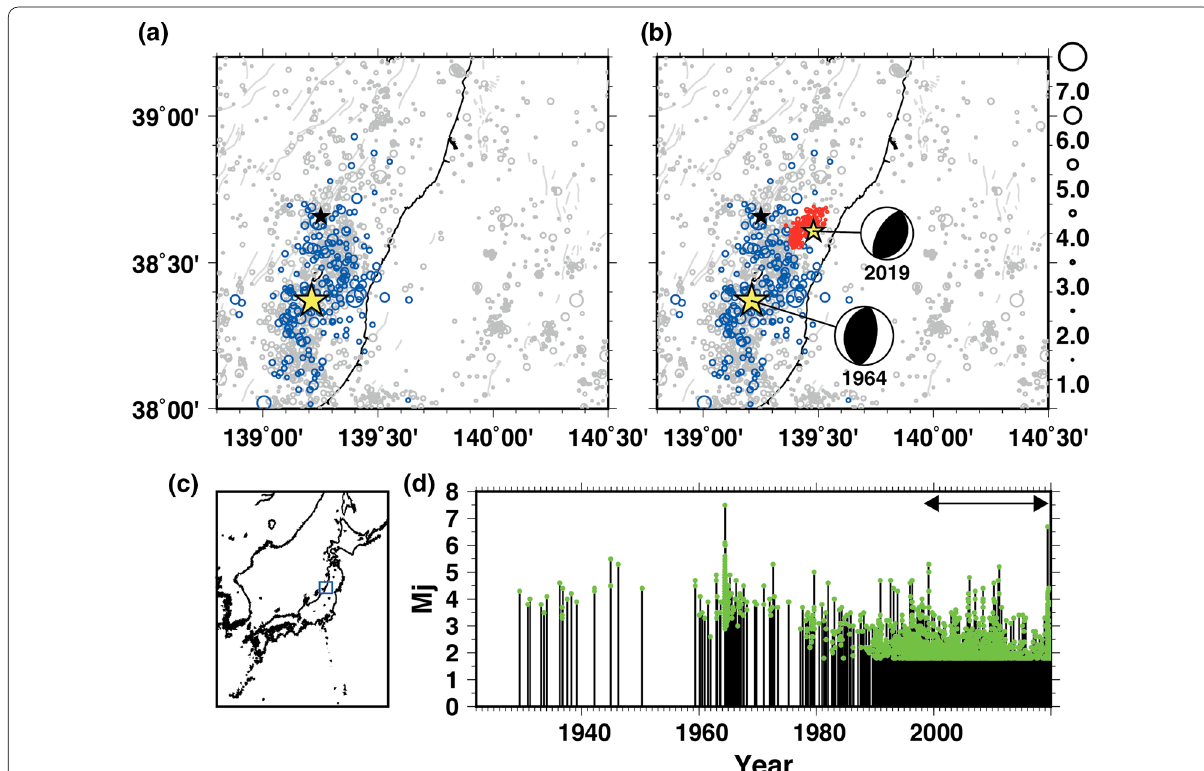
Fig. 1 Seismicity in the study region. a Epicenter distribution of earthquakes before the 2019 Yamagata-Oki earthquake. The yellow star is the epicenter of the 1964 Niigata earthquake. The black star is the epicenter of the M j 5.9 aftershock that occurred immediately after the 1964 Niigata earthquake (redetermined by Miyaoka et al. (2019)). Blue circles denote the aftershocks that occurred within 24 h of the 1964 Niigata earthquake. Gray circles are the earthquakes that occurred before the 2019 Yamagata-Oki earthquake (1922–2019). Gray lines are the surface traces of active Quaternary faults. b Epicenter distribution of the earthquakes that occurred before and within 24 h of the 2019 Yamagata-Oki earthquake. The black star, southern yellow star, blue and gray circles, and gray lines are the same as in a . The northern yellow star denotes the epicenter of the 2019 Yamagata-Oki earthquake. Red circles denote the earthquakes that occurred within 24 h of the 2019 Yamagata-Oki earthquake. Focal mechanisms were estimated by JMA (2019 Yamagata-Oki earthquake) and Abe (1975) (1964 Niigata earthquake). c Regional map of Japan, with the study region indicated by the blue square. d Magnitude–time plot of the earthquakes (1922–2019) that occurred in the study region. M j shown in green. The two-way arrow indicates the time period used to estimate the HIST-ETAS